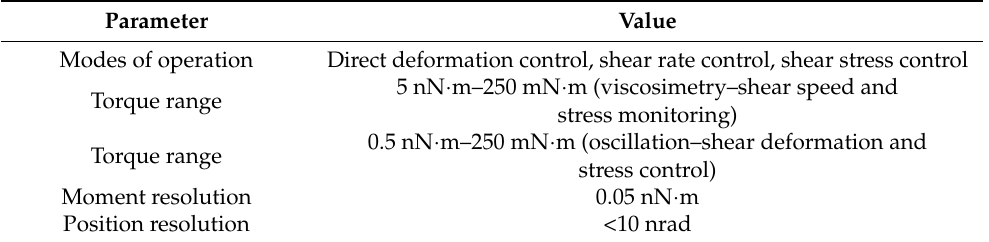
Table 7. The main technical characteristics of the rotary rheometer «Kinexus ultra +».